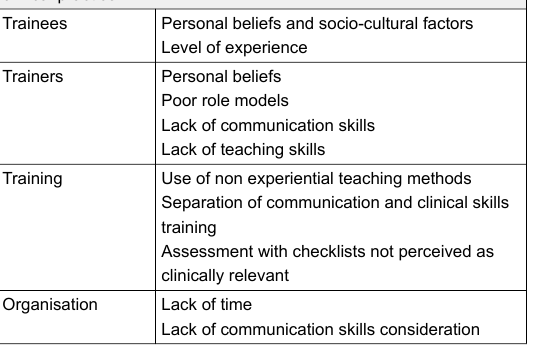
Table 1 : Barriers to communication skills learning and teaching in clinical practice. Trainees